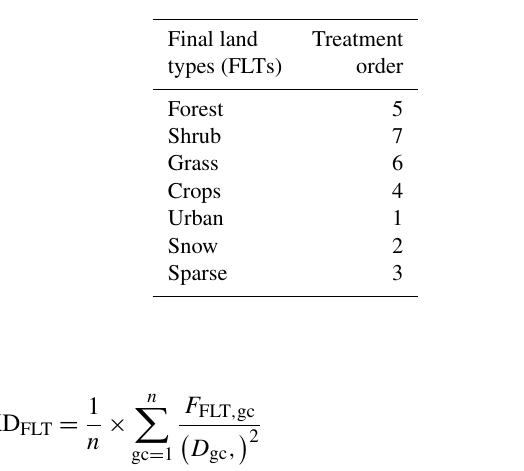
Table 4. User-defined treatment